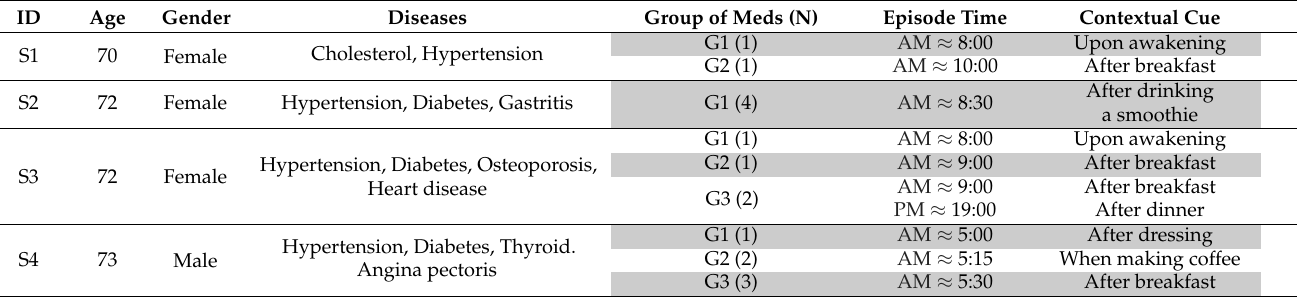
Table 1. Characteristics of the